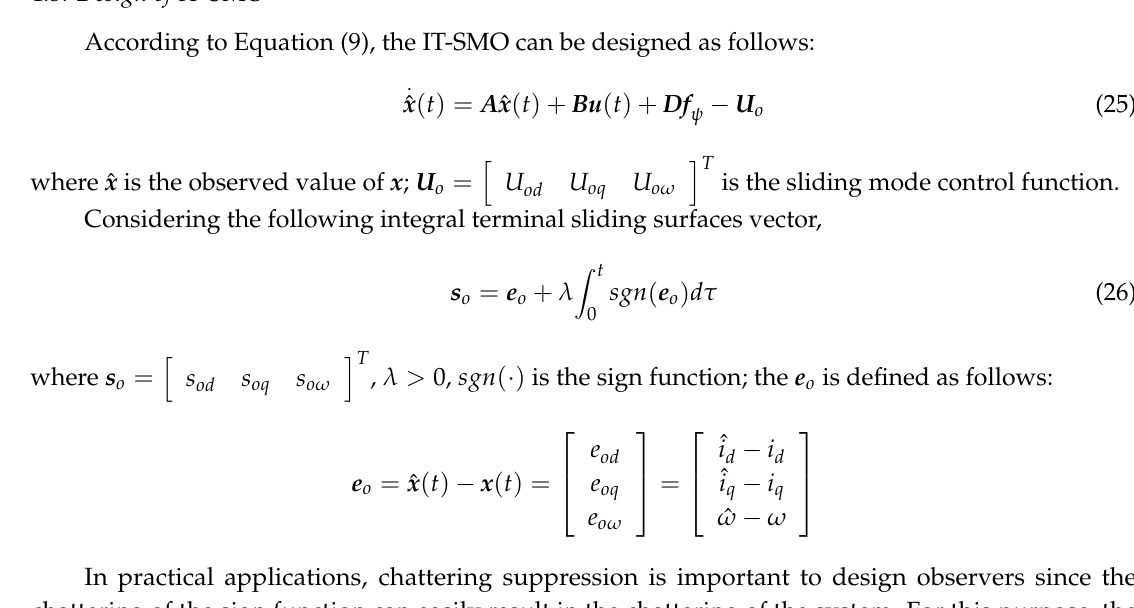
Figure 6. The block diagram of CRFTPC method with IT-SMO for PMSM.